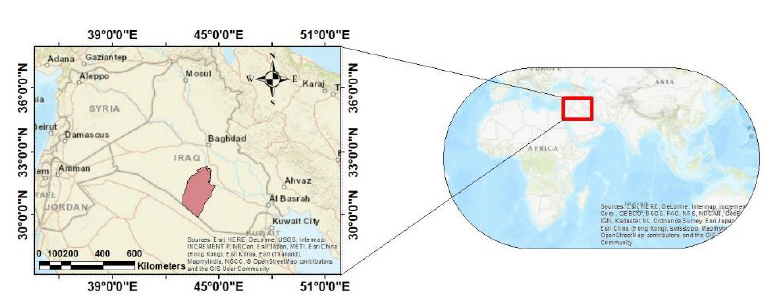
Fig. 1 The location of Najaf